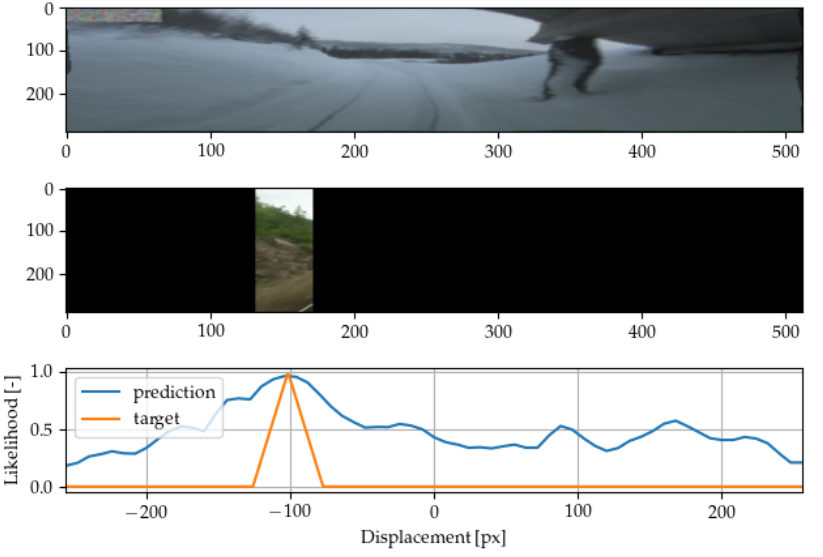
Figure 2. An example of the training process of the alignment method. The sample was generated using one image and a random cutout of the second image. Plotting the network output against the training target, one can see that the network is already approximating it reasonably